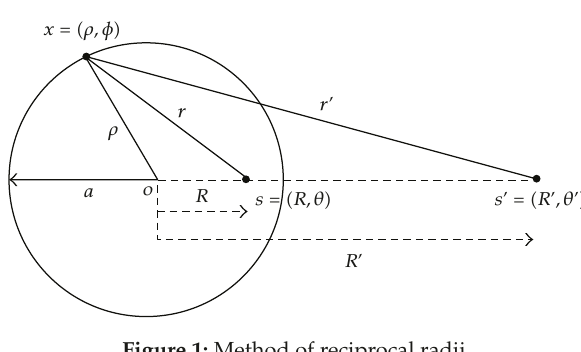
Figure 1: Method of reciprocal